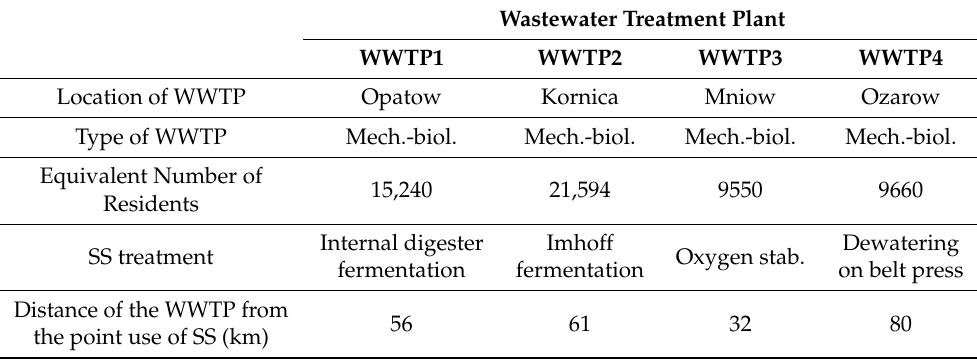
Figure 1. Location of WWTPs and potential sites of agricultural use of sewage sludge (own research). Table 2. Characteristics of WWTPs (own research).